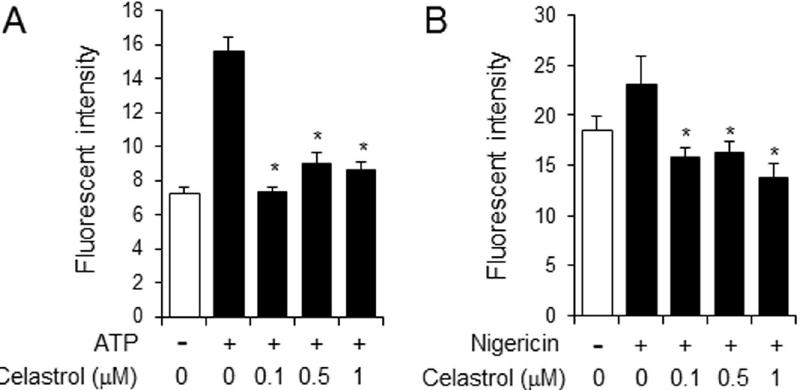
Figure 7. Celastrol suppresses the potassium efflux induced by ATP and nigericin in primary macrophages. Primary mouse macrophages were primed with LPS (100 ng/ml) for 4 hr. The cells were treated with celastrol for 1 hr and then stimulated with ( A ) ATP (5 mM) or ( B ) nigericin (10 μ M) together with potassium binding benzofuran isophthalate (PBFI)-tetraammonium salt for 1 hr. Values are means ± SEM (n = 3). * Significantly different from ATP or nigericin alone, p <